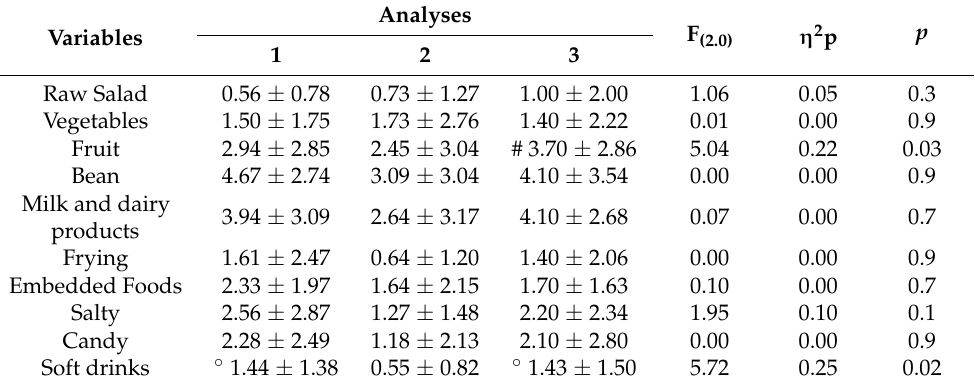
Table 5. Analysis of frequency and food consumption of children and adolescents with HIV over